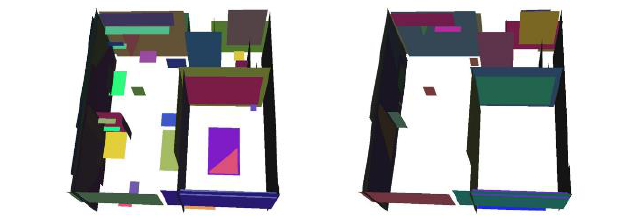
Figure 9. RANSAC planar extraction results; a) applied to the raw point cloud; b) applied to wall points detected by CNN. It can clearly be seen that the number of irrelevant planes declines, and a cleaner planar extraction is